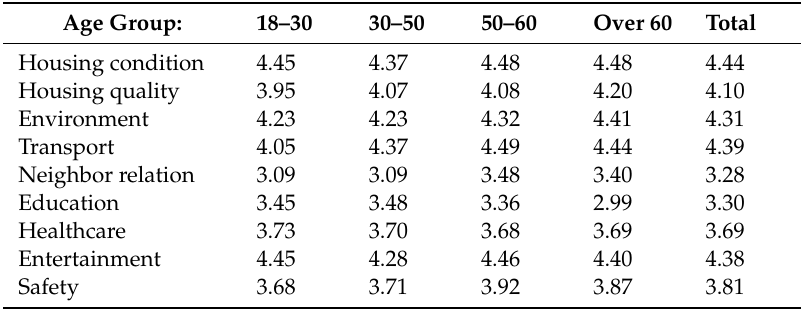
Table 1. Perception of change in the living